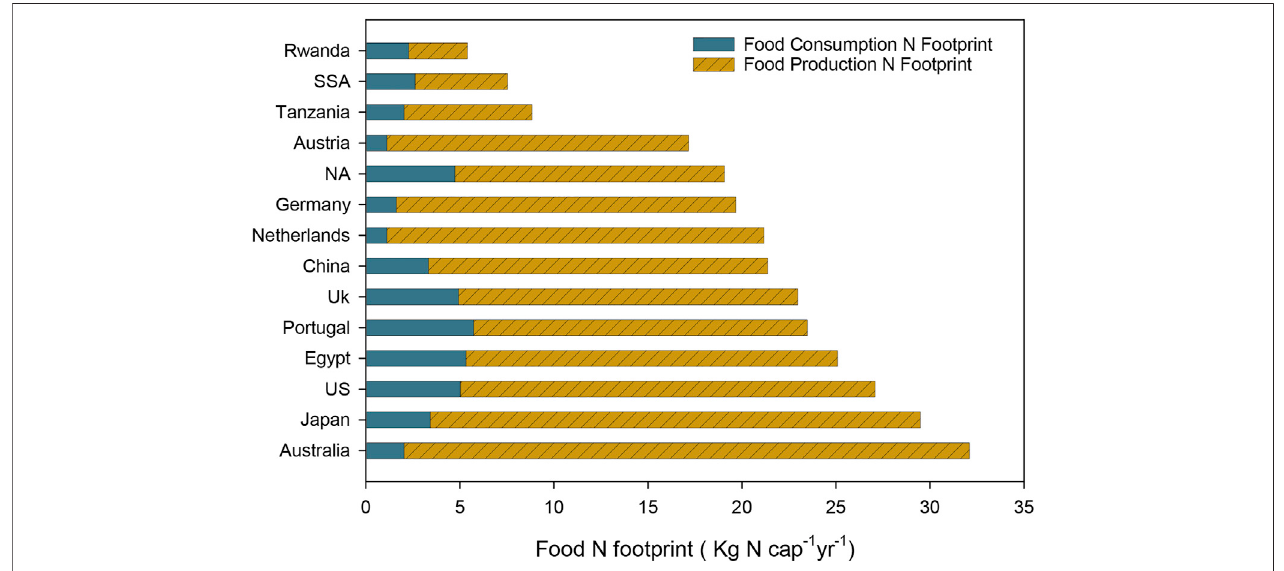
FIGURE12| ComparisonoftheNfootprintpercapitaofRwandawithothercountriesandregions[Sub-SaharaAfrica(SSA)andNorthAfrica(NA)]inthe2000s.We utilized the weighted NF food per capita for Rwanda, Tanzania, SSA, and NA.